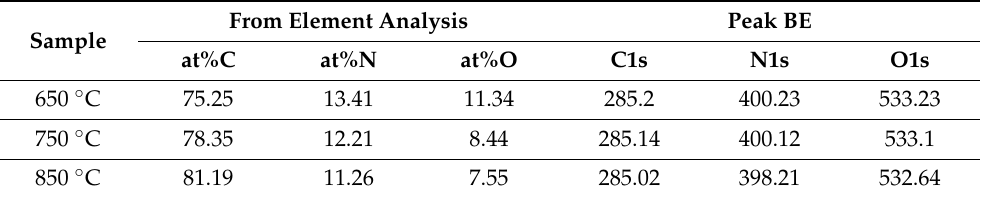
Table 2. XPS measurement results.